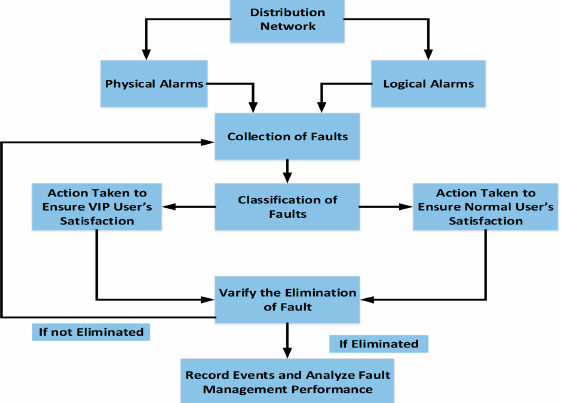
Figure 1. Data collection and classification of faults diagram.